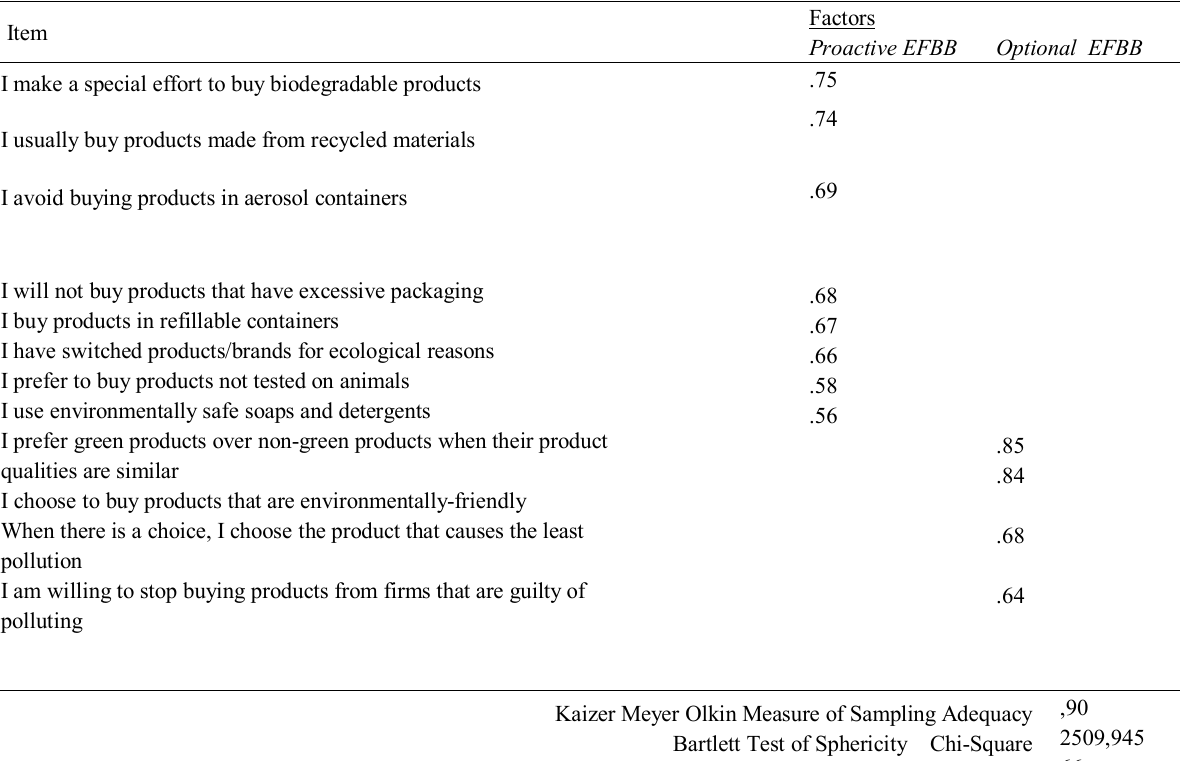
Table 2. Varimax rotated component matrix for factor analysis of the